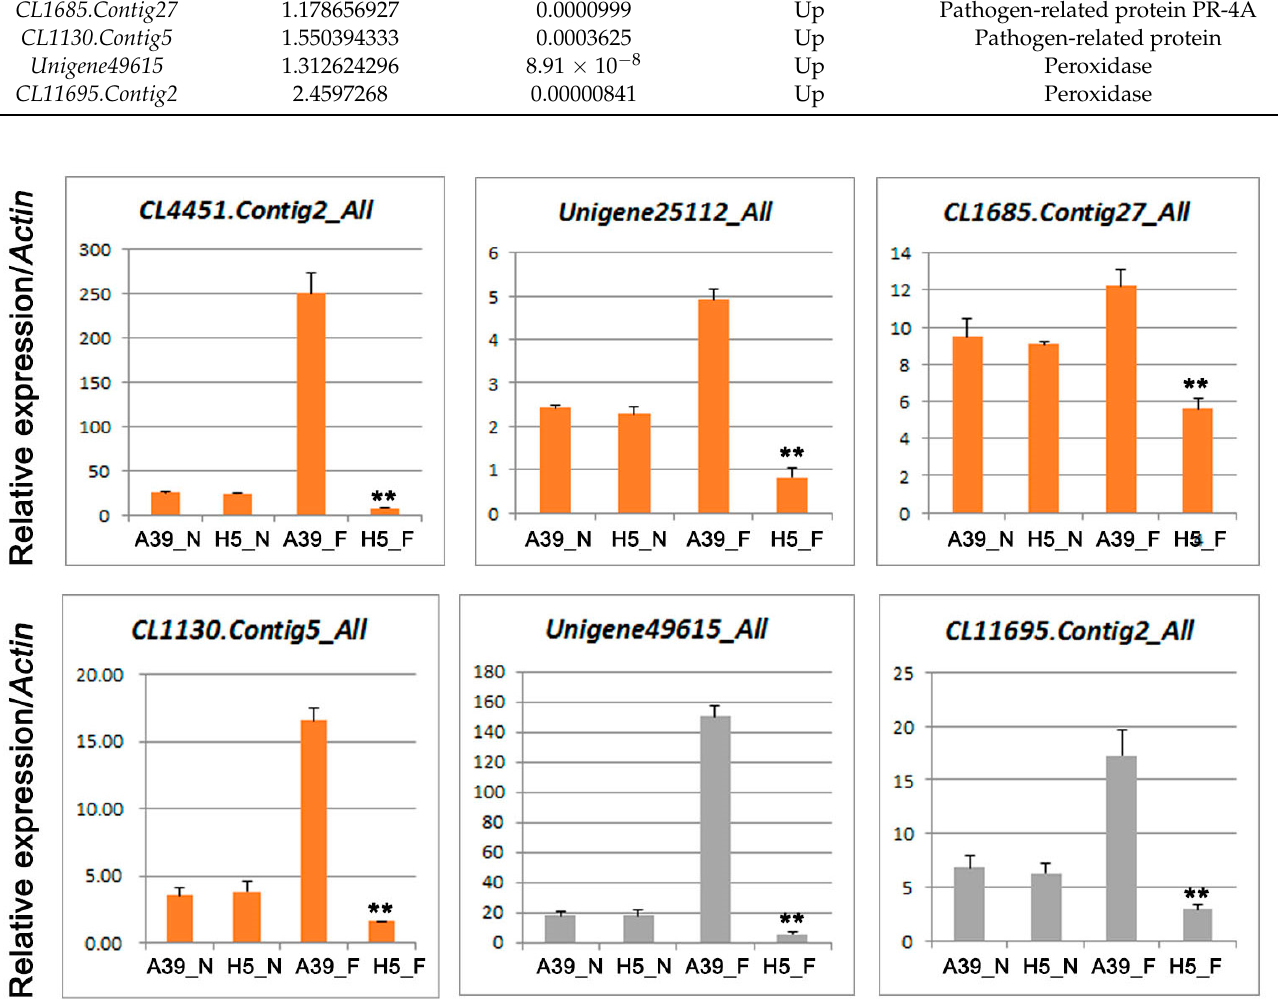
Figure 6. Relative expression of genes related to pathogen-related protein. Data is presented as the mean ± standard deviation (n = 9). Student’s t test: ** p ≤ 0.01.